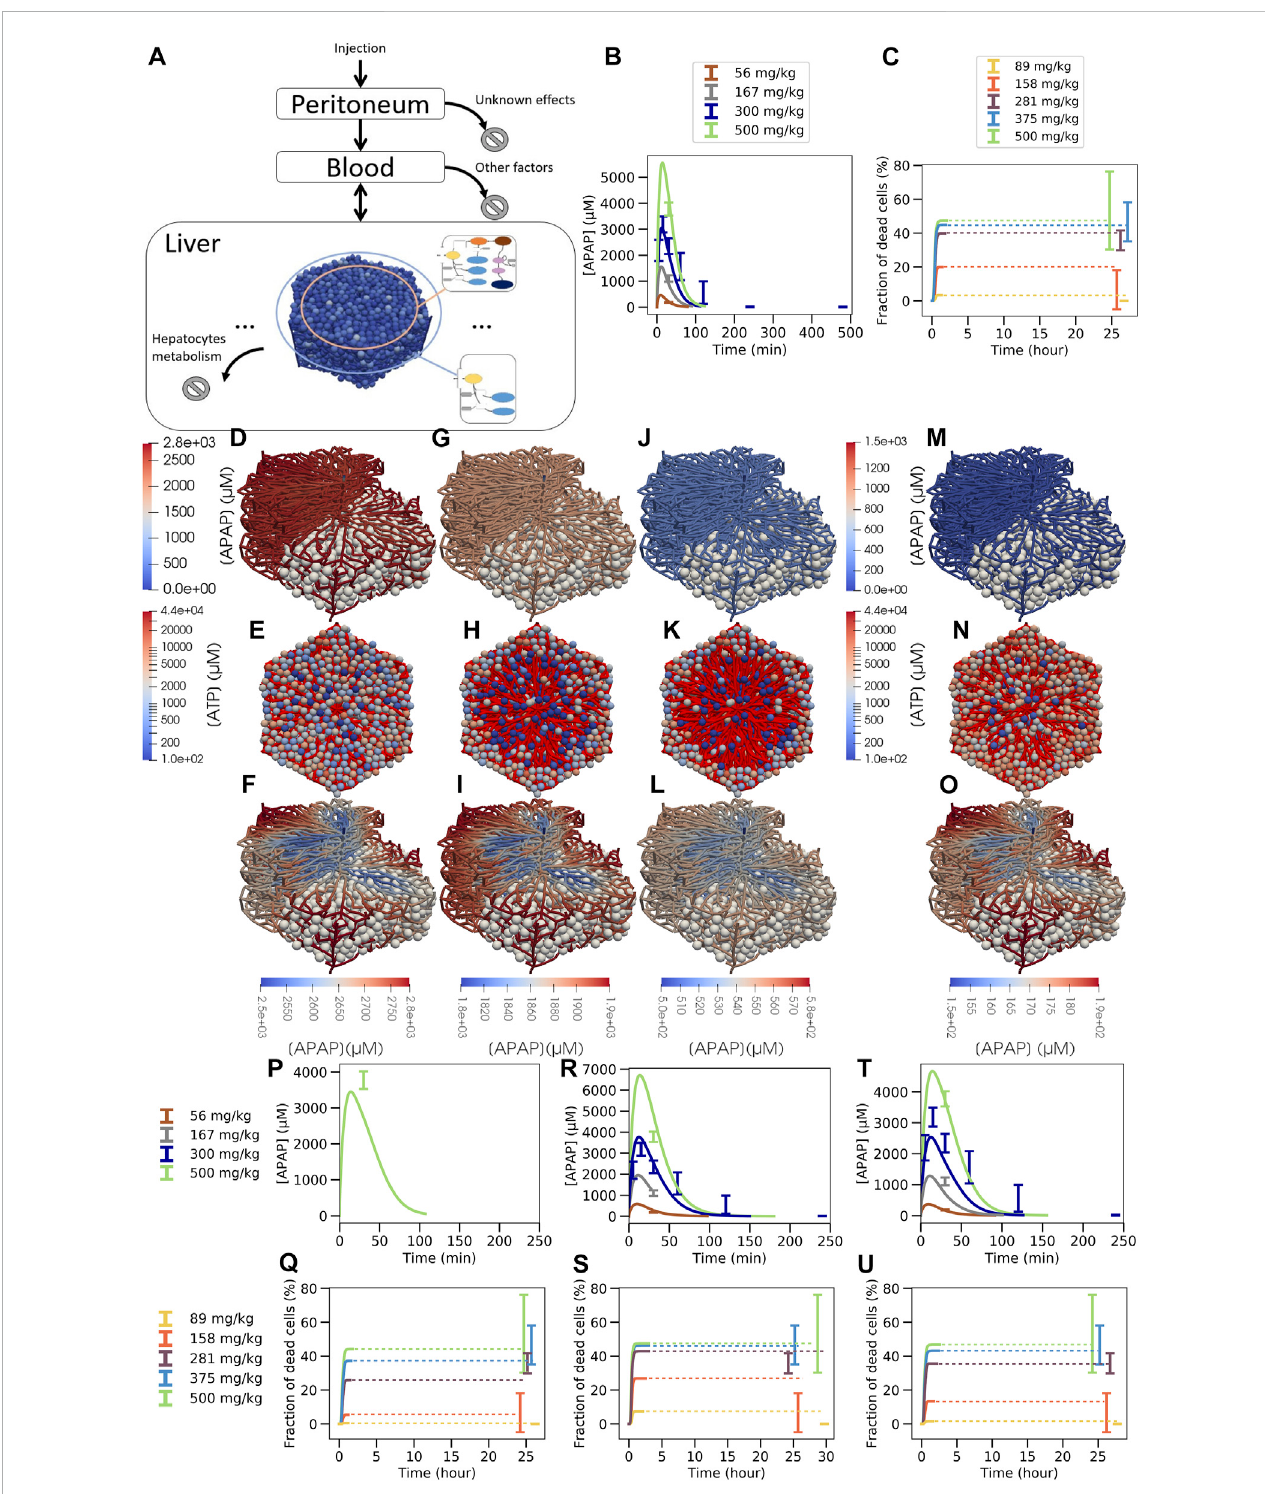
FIGURE 7 Multiscale model strategy. (A) Multiscale model involving a spatial-temporal liver lobule coupled to blood and peritoneum compartments, (B) APAP concentration in blood, (C) fraction of dead cells over time (dotted line is extrapolation after stationary state was reached). (D, G, J, M; F, I, L, O) : typical APAP- induced injury scenario in a quasi 3D-liver lobule showing cells as white spheres and the sinusoidal network as system of pipes with their APAP concentration. Fortheupperlefthalfofthelobulenocellsareshown.In (D,G,J,M) theAPAPconcentrationscaleischosentocomparethelobulesamongeachother,in (F, I, L, O) it is chosen fi ner to display concentration changes inside each individual lobule. (E, H, K, N) each displays a liver lobule from above with the spheres representinghepatocytes,coloredaccordingtotheirATPconcentration,whilea network ofredpipesdisplay thesinusoids. (D) 3Dlobulefor a281 mg/kgdose and (E) equivalent 2D representation 15 min after injection, (F) the same lobule with minimum APAP concentration value set at 2500 µM (see scalebar), (G,H,I) the lobule 30 min after injection, minimum concentration value set at 1800µM, (J,K,L) 1 h after injection with minimum value set at 500µM, (M-N-O) 1 h after injectionfora158 mg/kgdosewithminimumvaluesetat150 µM.ForD,F,H,JcolormapstheAPAPconcentrationinthebloodvasculature,for (E,G,I,K) color